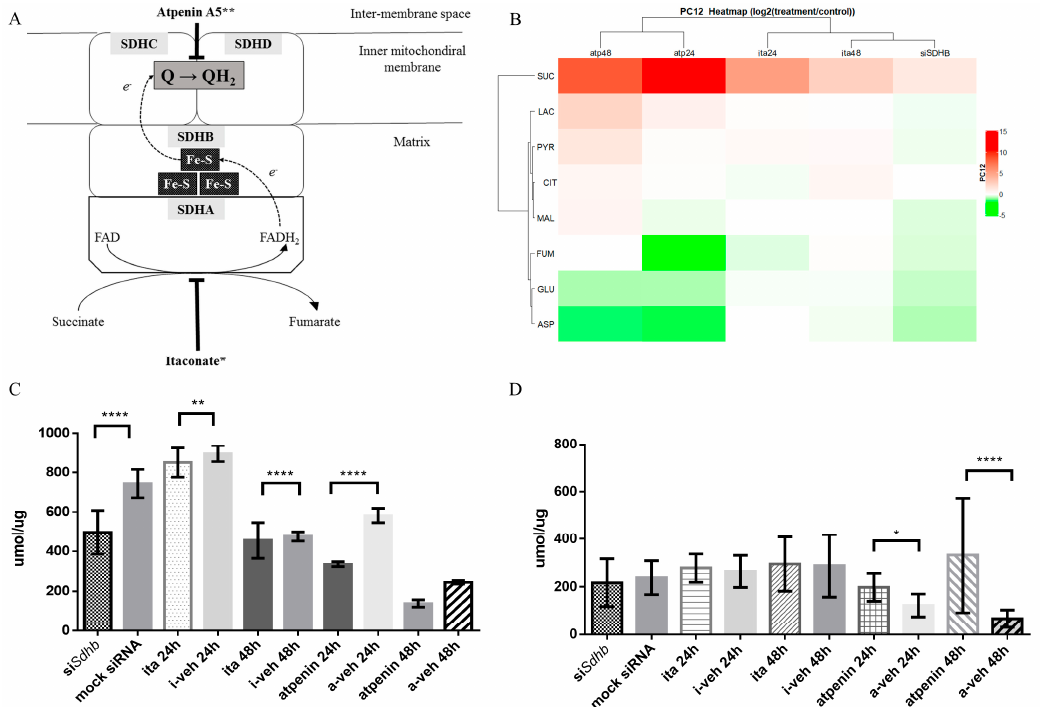
Figure 4. Inhibitory method specific changes in cellular metabolomics of PC12 cells after SDH inhibition. ( A ) Schematic illustration of Complex II. FAD: flavin-adenin-dinucleotide; FADH2: reduced FAD; Fe-S: iron- sulfur cluster; Q: coenzyme-Q or Ubiquinone; QH2: ubiquinol; SDHA: succinate dehydrogenase subunit A;